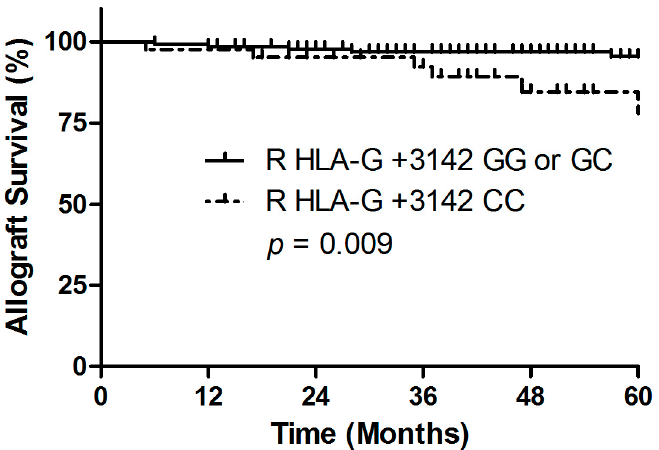
Figure 2. Association between the transplant recipient HLA-G +3142 C>G polymorphism and 5 year allograft survival. Recipients with a HLA-G +3142 CC genotype had a significantly reduced allograft survival. Table 2. The genotype distribution and allele frequencies of the +3142 C>G (rs1063320) gene polymorphism in living-donor kidney transplant recipients ( A ) and the corresponding donors; ( B ) with respect to allograft loss. 166 Soluble HLA-G molecules are of clinical relevance and exhibit equal immunosuppressive properties as their membrane bund counterparts [17]. In an attempt to identify a predictive marker for CMV infection based on sHLA-G levels, we quantified soluble molecule concentrations in patient sera. In contrast to previous studies that linked levels of sHLA-G to the HLA-G +3142 C>G SNP [19] there was no significant association in our cohort (data not shown). The sHLA-G levels prior kidney transplantation were significantly elevated in recipients exhibiting productive CMV replication after transplantation compared to those with no viral replication (38.9 ± 13.0 ng/mL vs. 25.1 ± 1.74 ng/mL; p = 0.04). After transplantation, the sHLA-G levels dramatically decreased (sHLA-G before 26.8 ± 16.7 ng/mL vs. after transplantation 6.1 ± 4.8 ng/mL; p = 0.0002). Soluble HLA-G levels remained nearly twice as high in recipients with CMV reactivation without reaching the level of significance (10.32 ± 1.73 vs. 5.4 ± 0.9 ng/mL; p = 0.082). To evaluate whether post-transplant sHLA-G levels can help to identify patients with increased risk of CMV after transplantation, the ROC analysis was performed (Figure 3A). Using an optimal cut-off value of 6.1 ng/mL (AUC = 0.75, sensitivity: 80.0%, specificity: 75.8%), Kaplan-Meier curve analyses combined